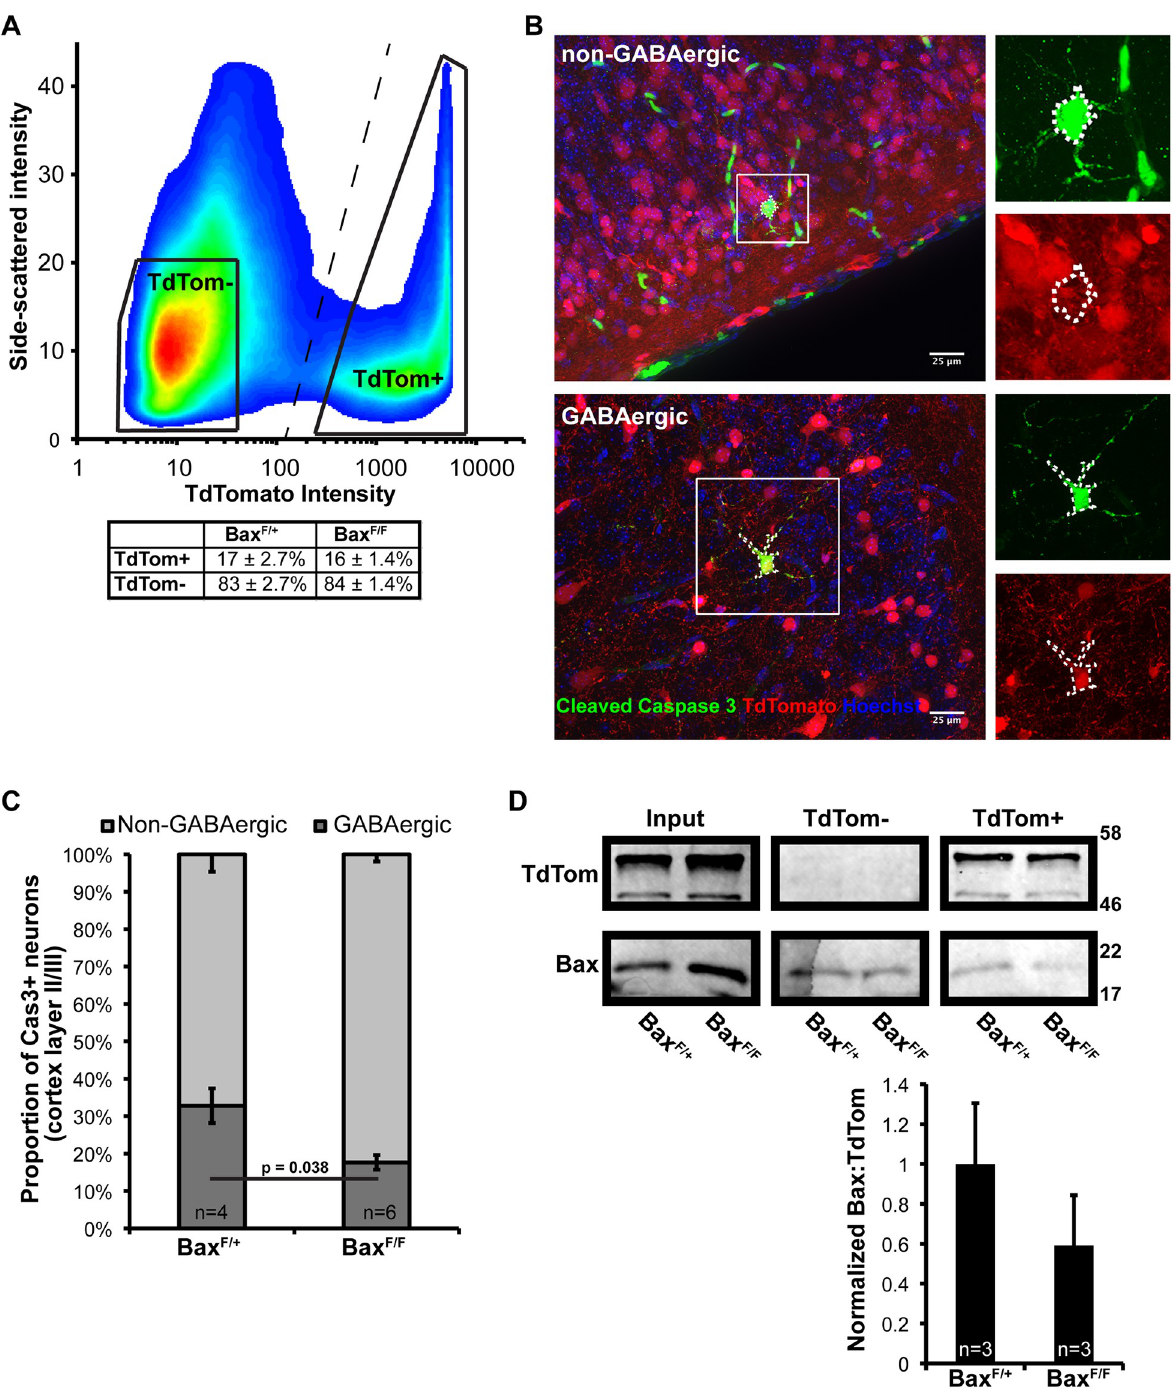
Fig 3. GABAergic interneuron population size and vulnerability to isoflurane exposure at PND 7. A) Cortical neurons from the Gad2-IRES Cre ; Bax Flox ; R26 TdTom/TdTom mice were quantified by FACS based on TdTomato fluorescence and side scatter. Demarcation of the GABAergic and nonGABAergic neuron populations for counting is shown as the dashed line. Solid trapezoids are representative of the collection gates used for sorting the cell populations used for subsequent western blot analysis in (D). Three animals per genotype from three separate litters were used for this analysis. B) Representative images of cleaved caspase 3 positive non-GABAergic (top) and GABAergic (bottom) neurons following exposure to isoflurane. C) Quantification of the relative proportion of non-GABAergic and GABAergic neurons in the total cleaved caspase 3 positive population in cortical layers II/III. D) Western blot analysis of cell suspension input for FACS and the isolated populations following sorting with quantification of the relative Bax protein content in the TdTomato positive population by band